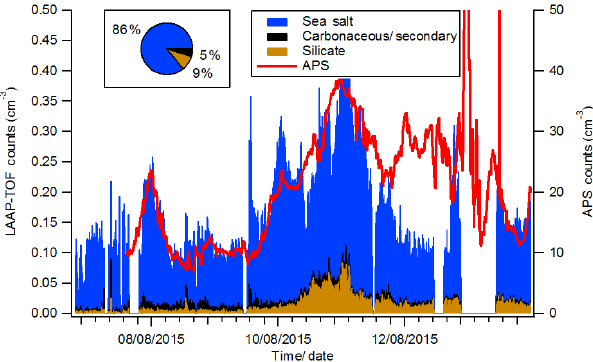
Figure 11. Time series of averaged number concentrations mea- sured by the LAAP-TOF and APS for a 7-day period at Praia, Cabo Verde, during the ICE-D campaign. Concentrations are calculated from 10min averaged number counts at a flow rate of 0.078 and 1Lmin − 1 for the LAAP-TOF and APS respectively. The calculated concentrations of sea salt, carbonaceous/secondary material, and silicates (as determined by fuzzy c-means clustering) are stacked in the time series so that total number concentration measured by the LAAP-TOF is represented by the top of the filled area. The relative number concentrations of the main particle classes are displayed in the inset pie chart.